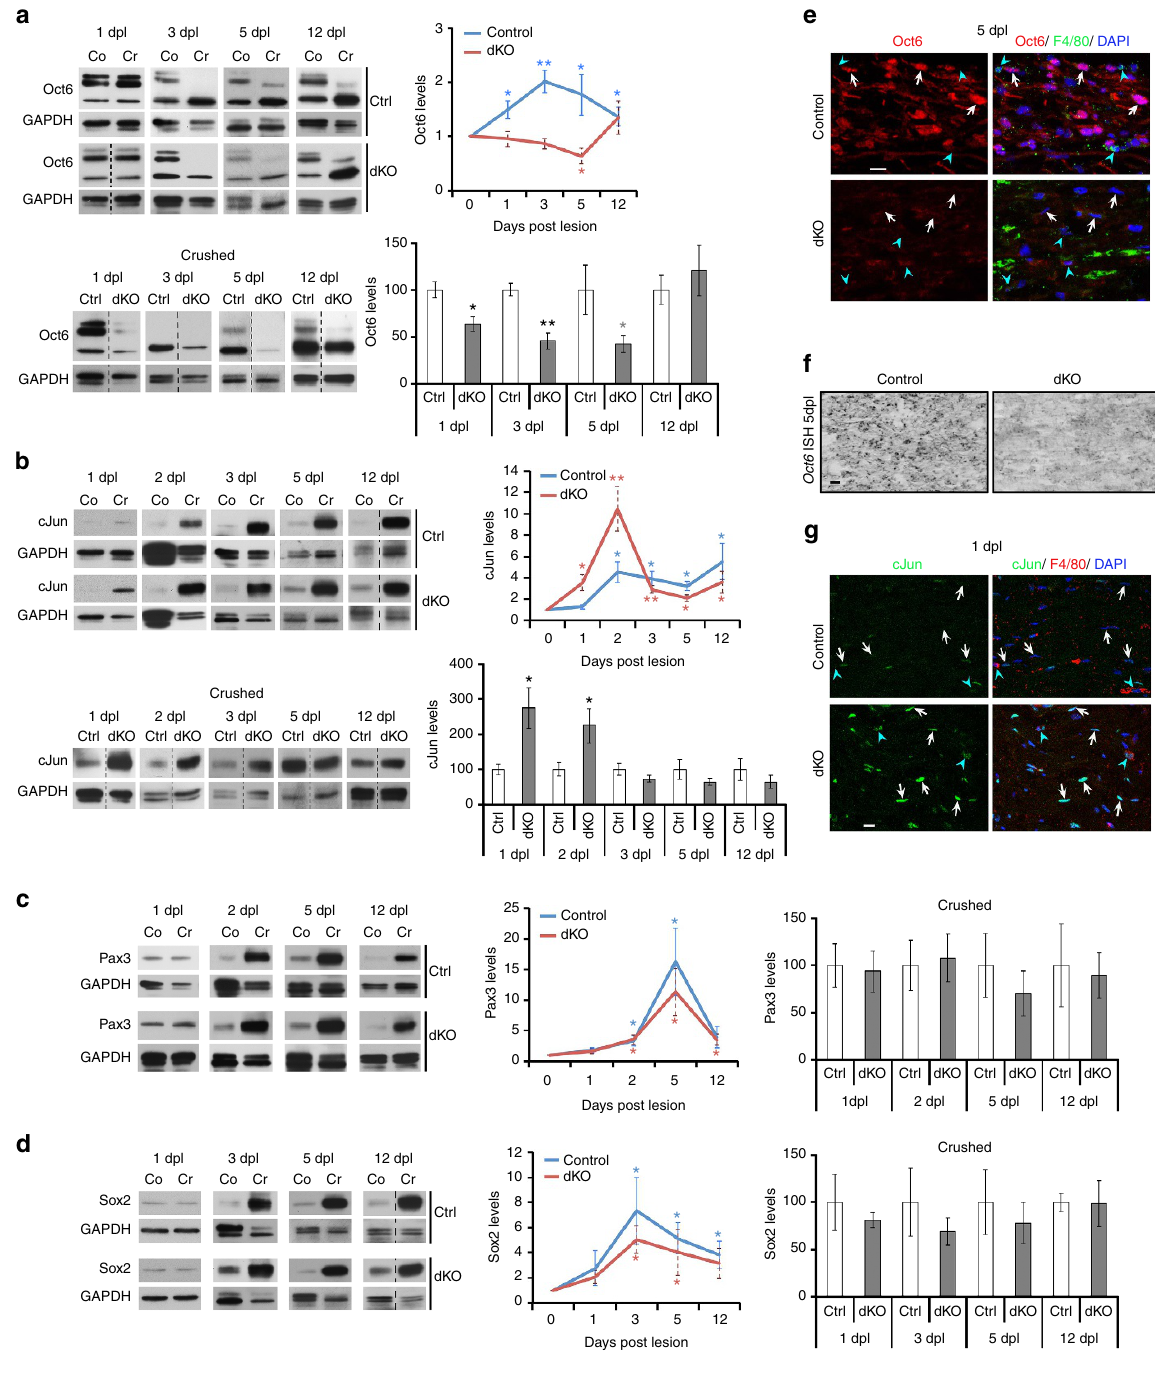
Figure 3 | Delayed Oct6 and earlier/higher cJun upregulation in dKO. Western blots and quantification normalized to GAPDH of ( a ) Oct6, ( b ) cJun, ( c ) Pax3, and ( d ) Sox2 in crushed (Cr) and contralateral (Co ¼ 1) nerves of control (Ctrl) and dKO, showing delayed Oct6 upregulation and earlier/higher cJun upregulation in dKO. Of note: the double band at B 52kDa and the lower band at B 42kDa detected by the Oct6 antibody were quantified and added together in the graph. Dashed lines: samples run on the same gel, but not on consecutive lanes. In a – d , coloured graphs quantify protein levels in Cr compared to Co, and grey/white bar graphs quantify protein levels in dKO compared with Ctrl crushed nerves. ( e , g ) Co-immunofluorescence of Oct6 (red, e ) at 5 dpl or of cJun (green, g ) at 1 dpl with the macrophage marker F4/80 (green in e , red in g ) and DAPI labelling (nuclei) in control and dKO nerves showing decreased Oct6 and increased cJun levels in SCs of dKO compared with control nerves. White arrows indicate SCs (F4/80-negative cells with elongated nuclei) and blue arrowheads indicate macrophages (F4/80-positive cells). ( f ) Oct6 in situ hybridization in control and dKO nerves at 5 dpl showing decreased Oct6 transcript levels in dKO. Sample size: ( a – d ) 5 animals per group for 1 dpl, 2 dpl and 3 dpl, and 6 or 9 animals per group for 5 dpl and 12 dpl; ( e – g ) 3 animals per group. One-tailed (grey asterisk; blue/red asterisks: Control Oct6 at 5 dpl, Control cJun at 5 dpl, dKO cJun at 12 dpl, Control Pax3 at 2 dpl, Control Sox2 at 3 dpl and 5 dpl) or two-tailed (black asterisks; blue/red asterisks: other values) Student’s t -tests, unpaired (bar graphs, and cJun at 2 dpl in coloured graph) or paired (coloured graphs, except for cJun at 2 dpl), P values: * P o 0.05, ** P o 0.01. Values, mean; error bars, s.e.m. Scale bar, 10 m